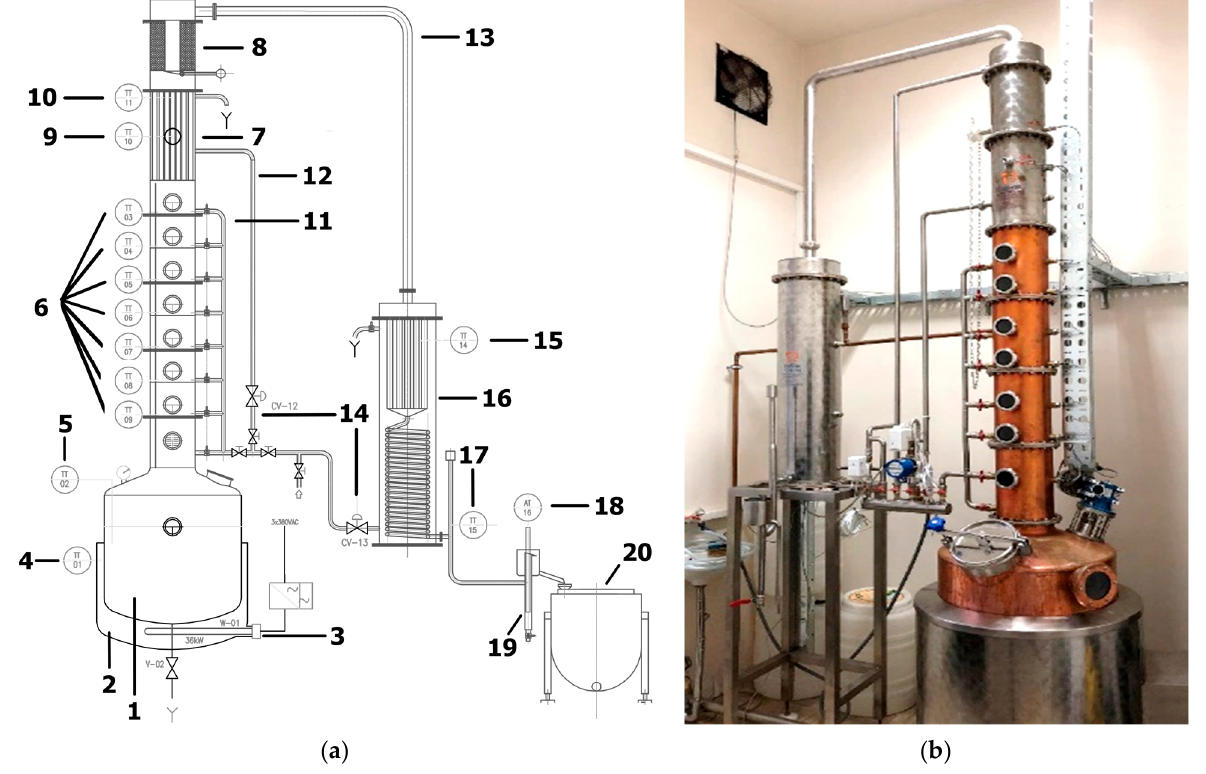
Figure 1. ( a ) Piping and instrumentation (P&ID) diagram of automated still with the following elements: 1. boiler with capacity of 100 L, 2. oil heating bath, 3. electric heater, 4. oil thermometer, 5. mash thermometer, 6. distillation column tray temperature thermometers, 7. dephlegmator, 8. catalyst, 9. dephlegmator coolant thermometer, 10. dephlegmator vapor thermometer, 11.